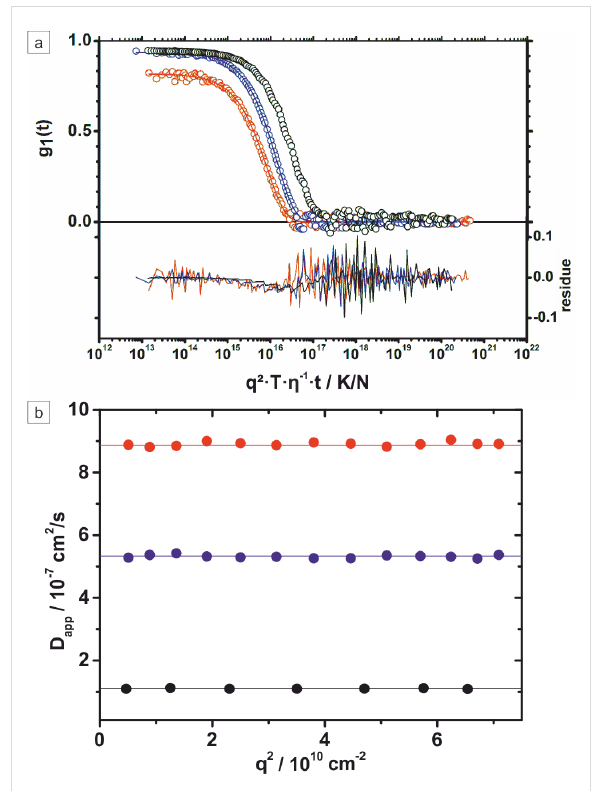
Figure 16: Dynamic light scattering results of Au (red dots), Au@Fe 3 O 4 (blue dots) dispersed in n-heptane, and Au@Fe 3 O 4 @SiO 2 (black dots) in water ( λ = 632.8 nm, T = 293 K, viscosity η : 0.41 cP n-heptane, 1.005 cP water). a) Universally scaled autocorrelation func- tions measured at scattering angle θ = 30° together with biexponential fitting function lines and corresponding residues. b) Apparent diffusion coefficients as a function of the scattering vector q 2 in the range of scattering angle 30° ≤ θ ≤ 150°.